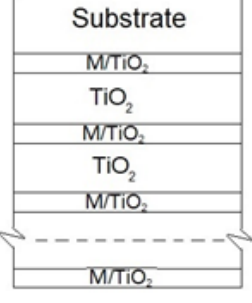
Figure 1. M-doped TiO 2 thin film structure. Table 1. Dopants concentration in samples and apparent rate constant k app (where OA is an oxalic acid solution). Dopants concentration was analyzed via X-ray photoelectron spectrometer (XPS)